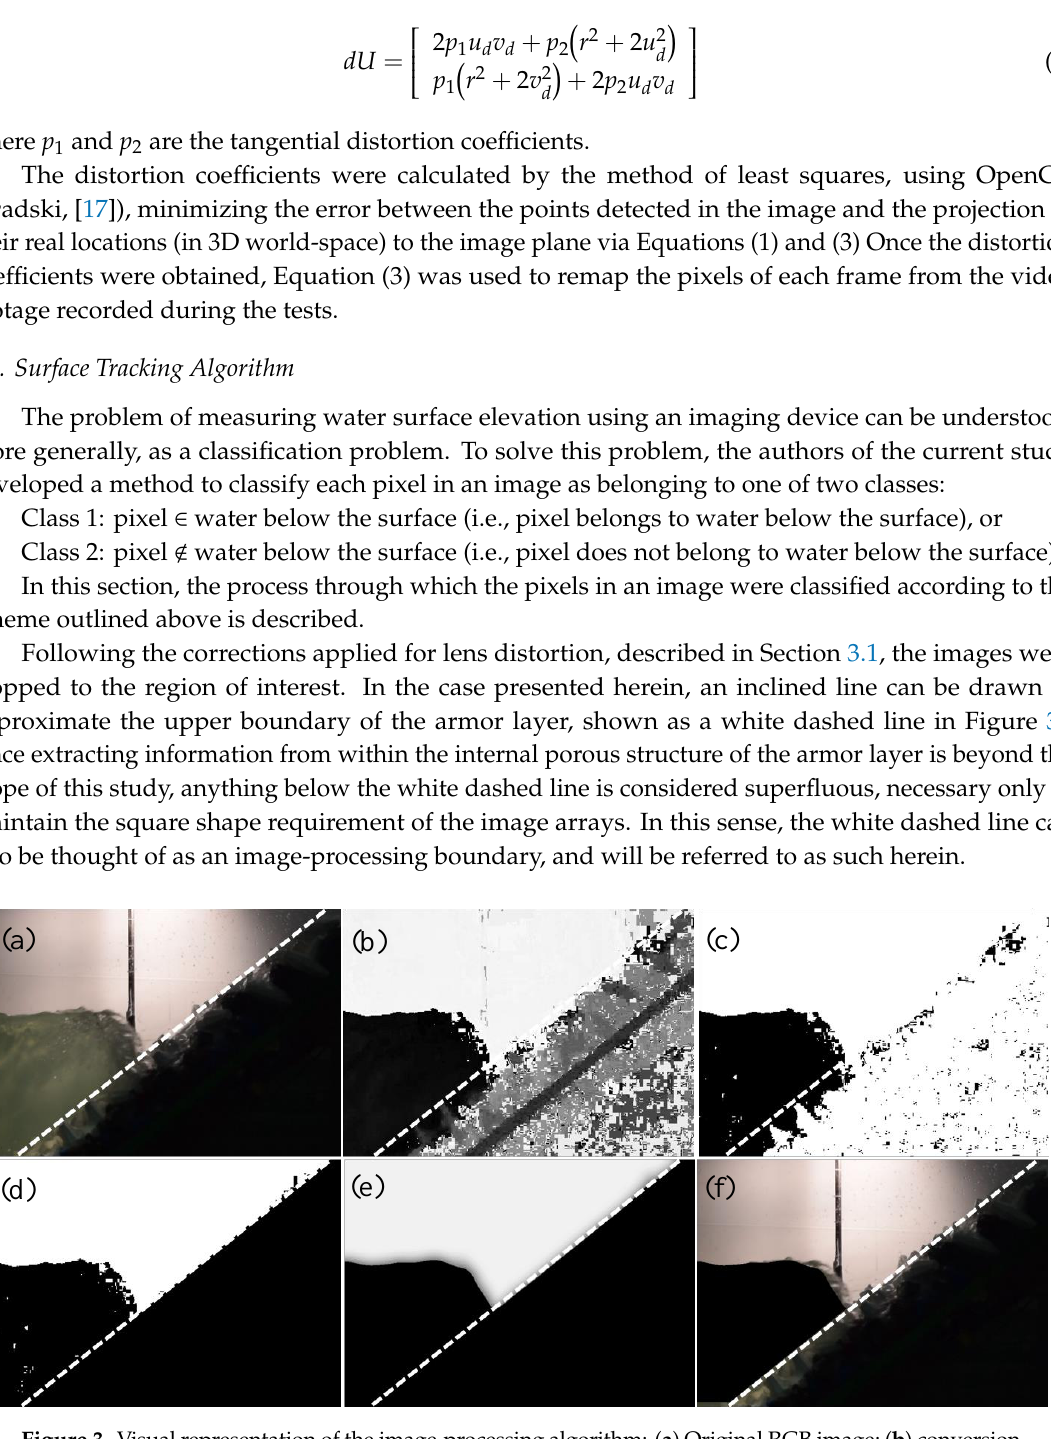
Figure 3. Visual representation of the image-processing algorithm: ( a ) Original RGB image; ( b ) conversion to hue; ( c ) threshold on hue; ( d ) boundary insertion; ( e ) Gaussian blur; and ( f ) boundary removal.